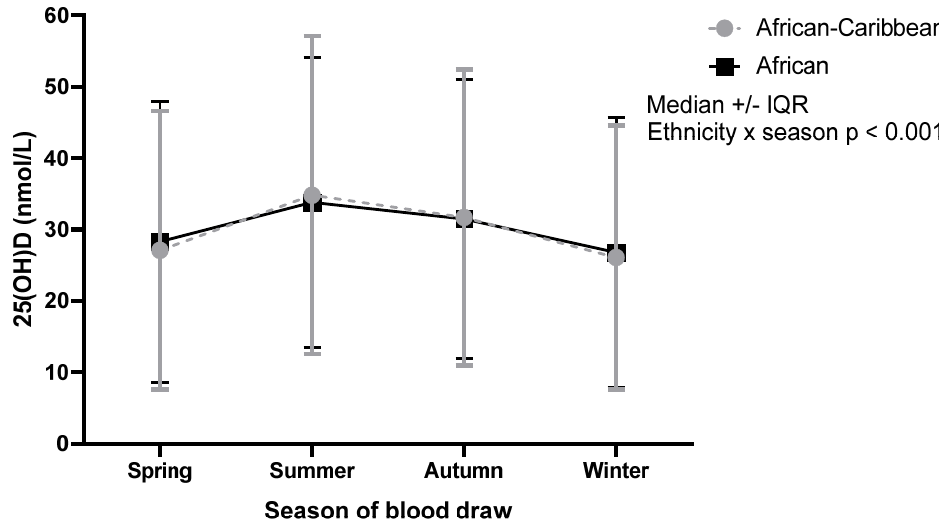
Figure 3. Concentration of 25(OH)D by season. Note: Each participant has one measurement in one season, therefore this graph does not show repeated measures. There was a statistically significant interaction between ethnicity and season. Both groups reported the highest median 25(OH)D concentrations in summer and the lowest in winter. p -Values from two-way ANOVA.